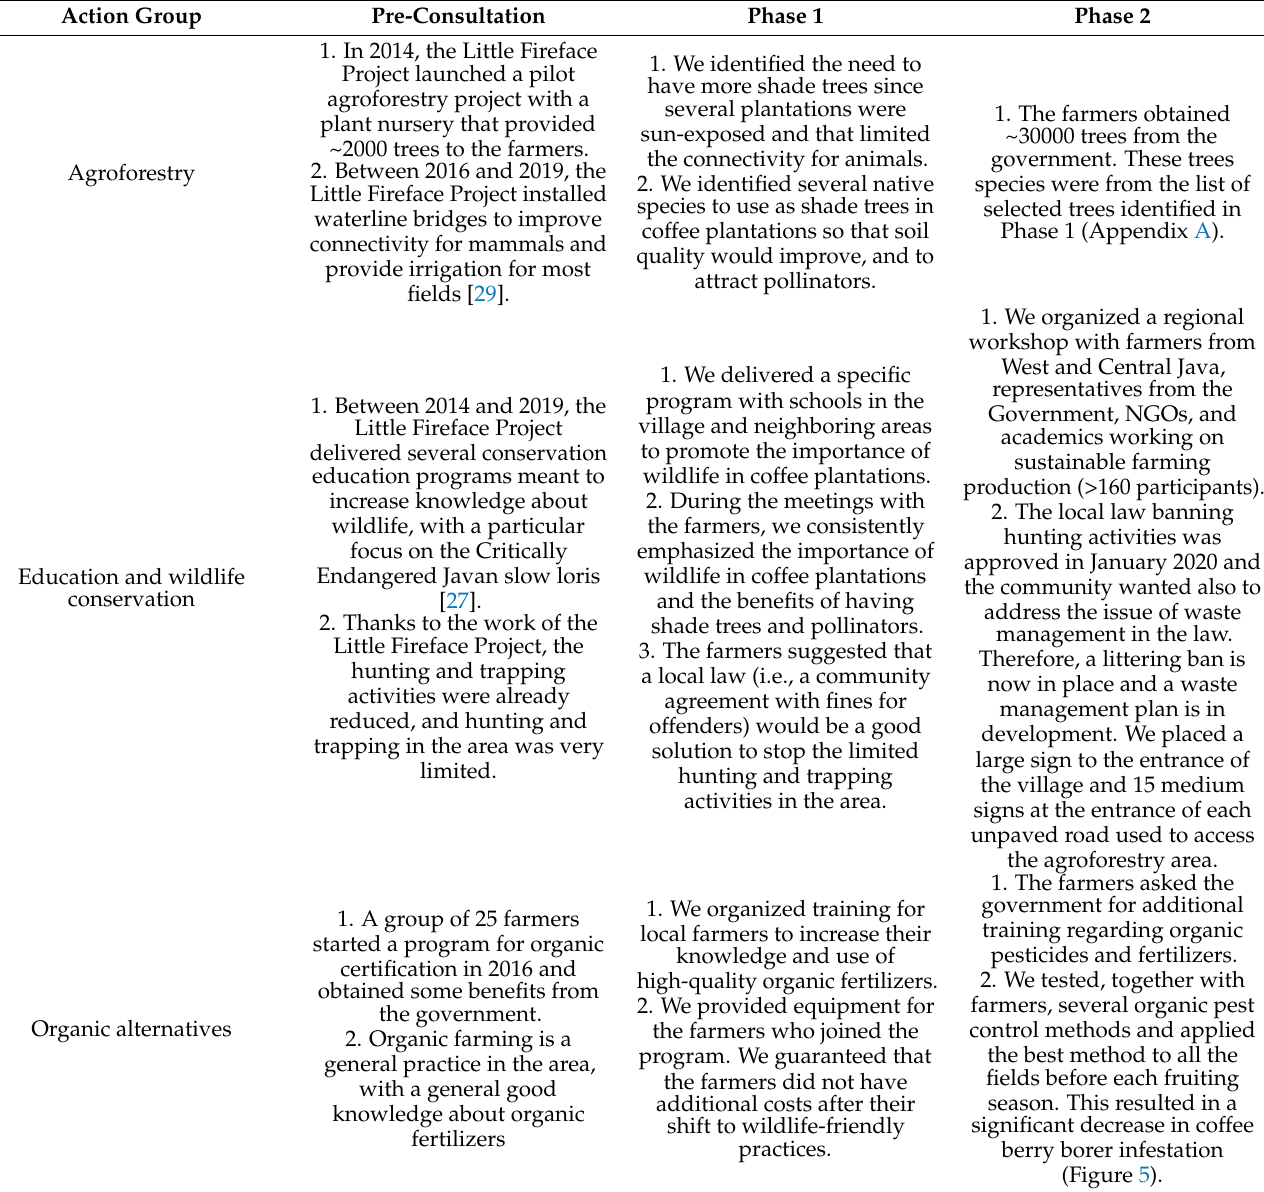
Table 3. Actions taken by the ~400 coffee farmers in Cipaganti and Pangauban, West Java, at different stages of the program. Some actions were already present before the program started, other actions were implemented after different phases of stakeholder consultation and